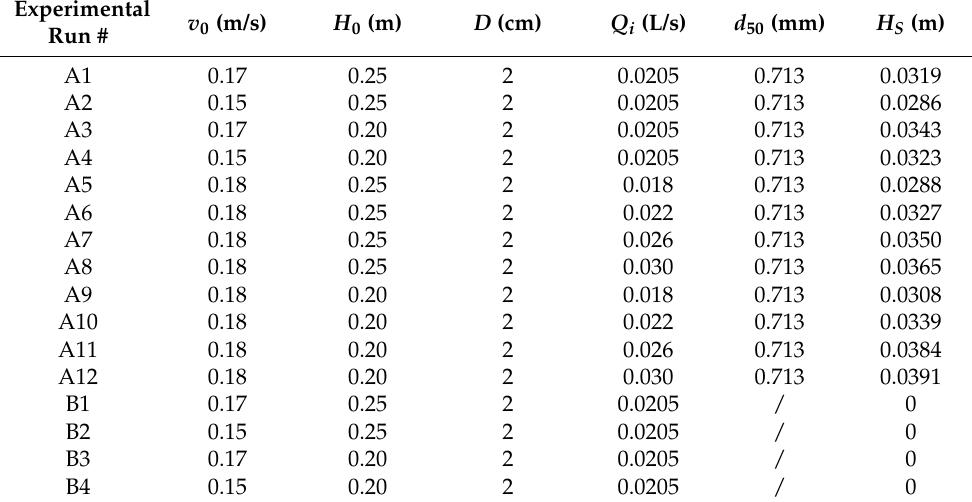
Table 1. Experimental conditions.